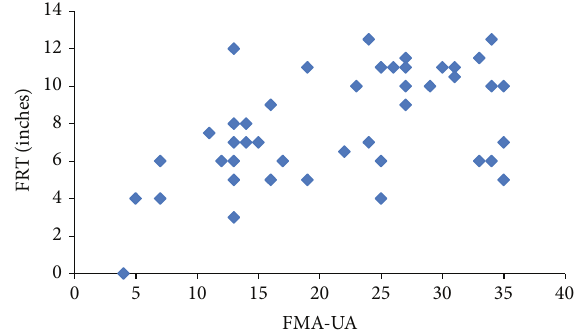
Figure 2: Showing the relation between the upper arm subscore of Fugl-Meyer Assessment (FMA-UA) and Functional Reach Test